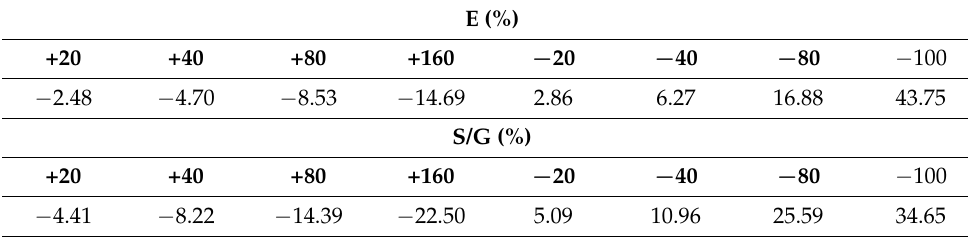
Table 7. The response of global solar irradiance to changes in absorbing or scattering factors calculated using Equation (3), e.g., changing rates of global solar irradiance (%) caused by the changes in one factor (%), while other factors are kept at their original levels under S/G < 0.80